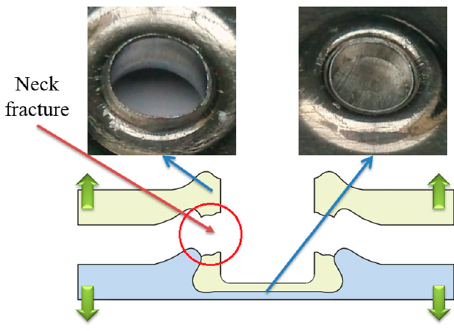
Figure 14. Neck fracture mode in the tensile test.